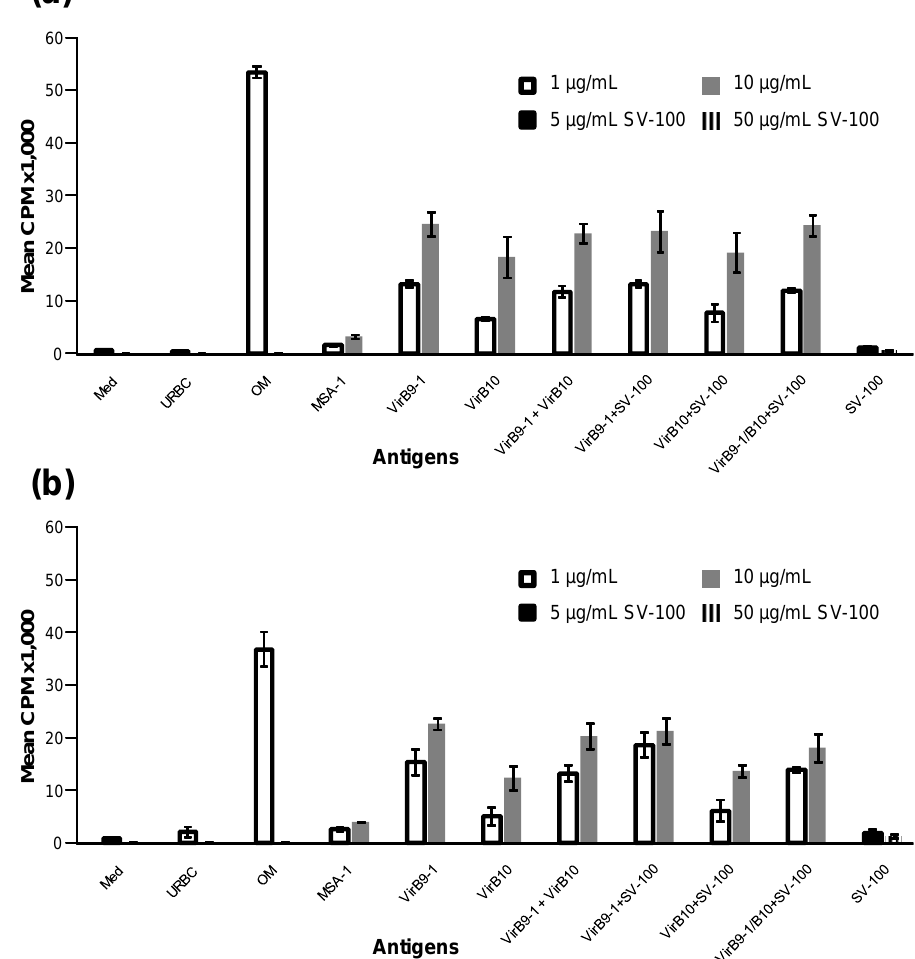
Figure 5. A. marginale -specific T-lymphocyte proliferation responses to VirB9-1 and/or VirB10 alone or adsorbed onto SV-100. Two-week T-cell lines established from A. marginale outer membrane (OM) -immunised calve numbers; 1 ( a ) and 2 ( b ) were tested for proliferation against 1 µg/mL and 10 µg/mL of VirB9-1 and/or VirB10 antigens alone or adsorbed onto SV-100 and; Med; media only (negative control), uninfected red blood cell membranes (URBC); Uninfected red blood cell membranes (negative control), OM; A. marginale outer membrane (positive control), merozoite surface antigen-1 (MSA-1); Babesia bovis merozoite surface antigen-1 (negative control protein), SV-100; SV-100 nanoparticles alone, tested at concentrations of 5 and 50 µg/mL. Error bars indicate standard deviation.